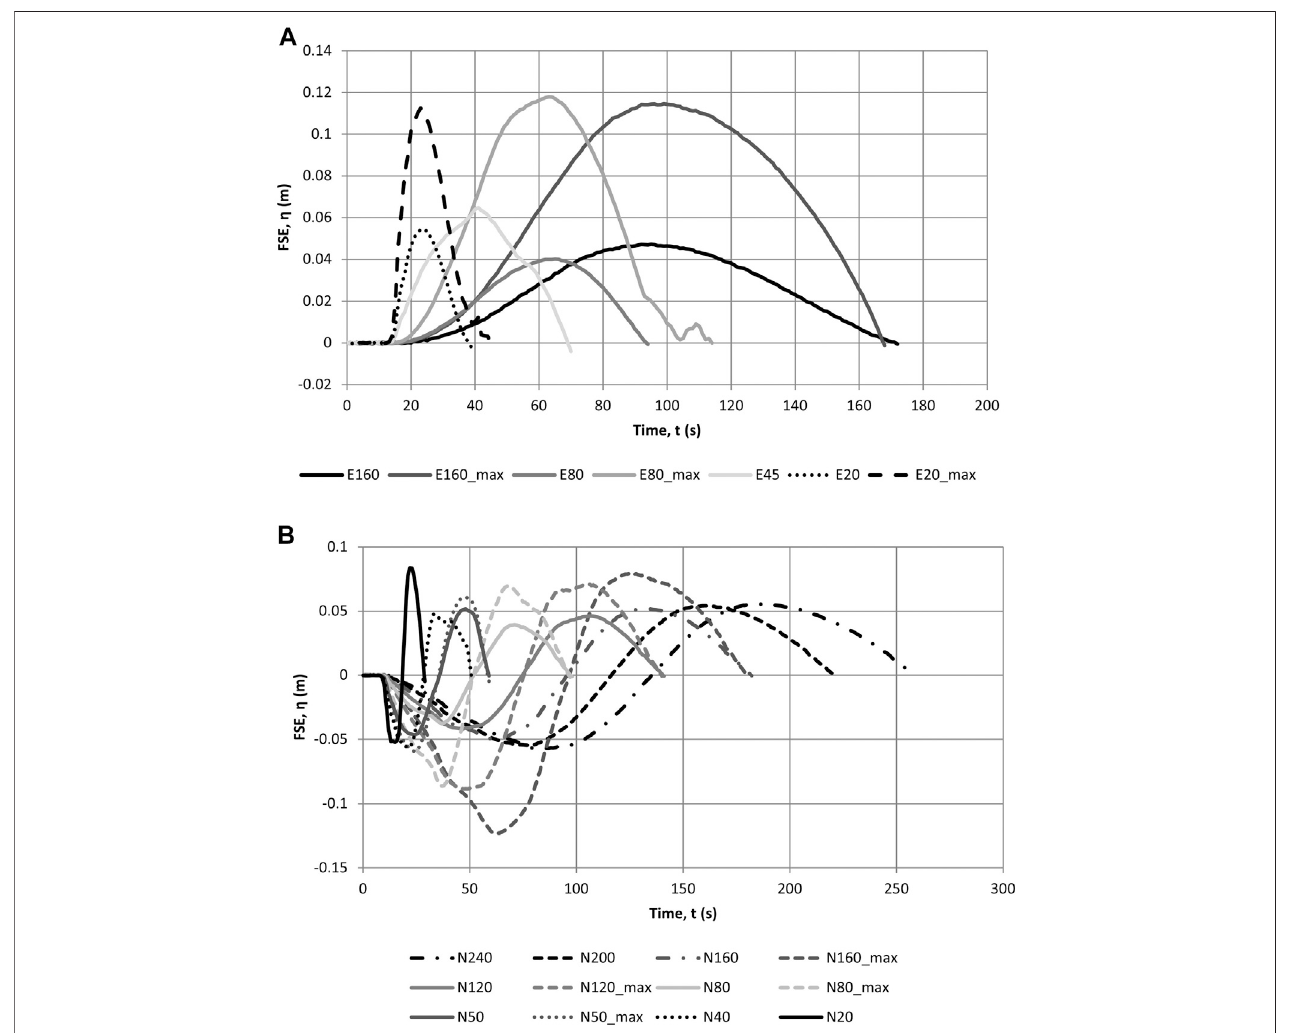
FIGURE 11 | Calibrated crest only (elevated) waves (A) and N-waves (B) using third generation TS, measured at the toe of the bathymetry.